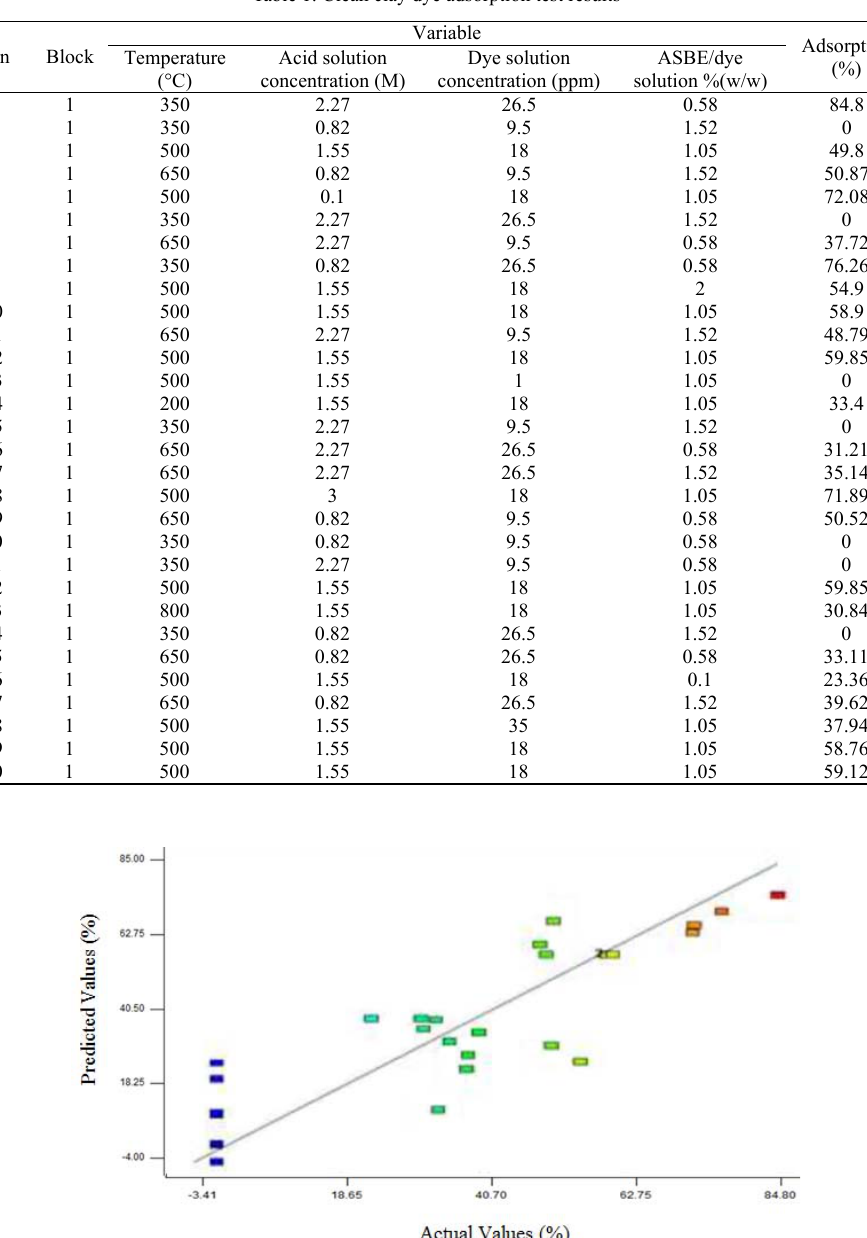
Table 1: Clean clay dye adsorption test results